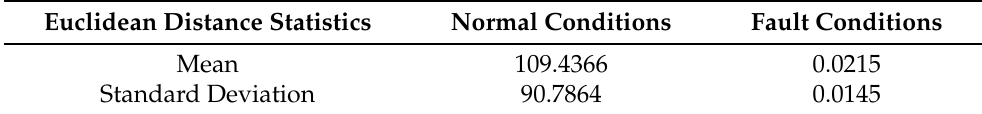
Table 7. 100 Ω fault statistics.